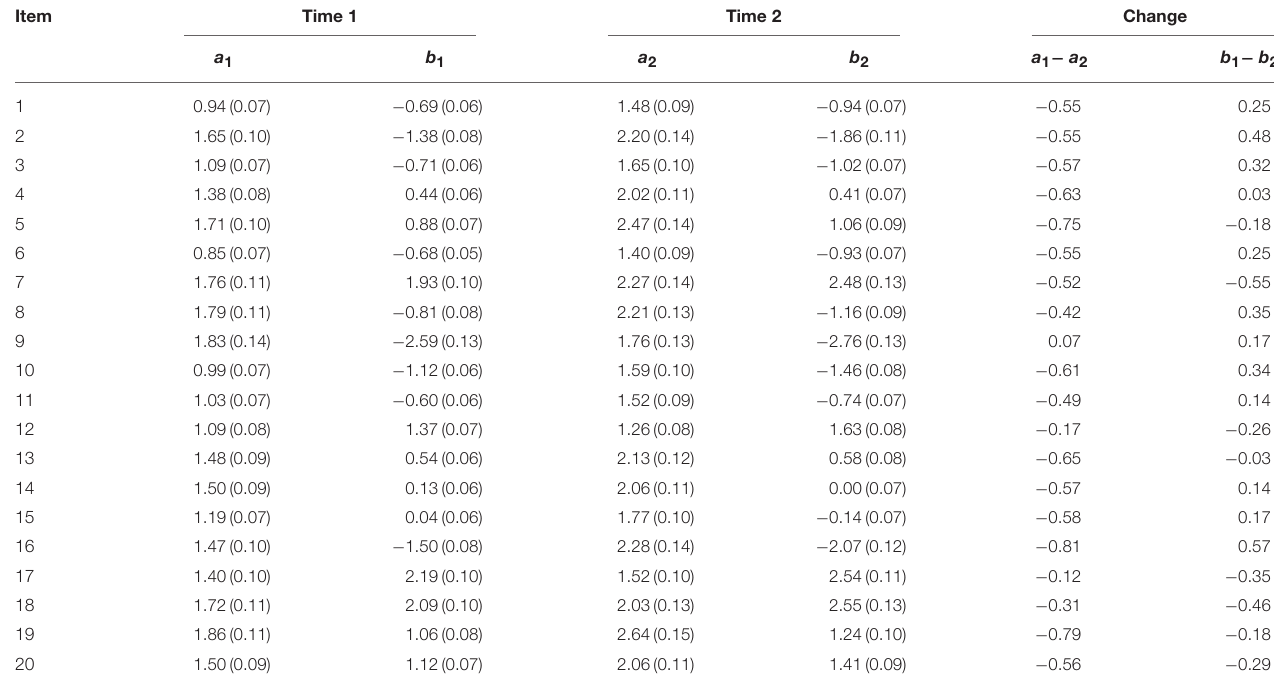
TABLE 7 | Fitting data generated from mixture IRT to unidimensional 2PL IRT model: Condition 2 (Increase in item discrimination for Group 1 at Time